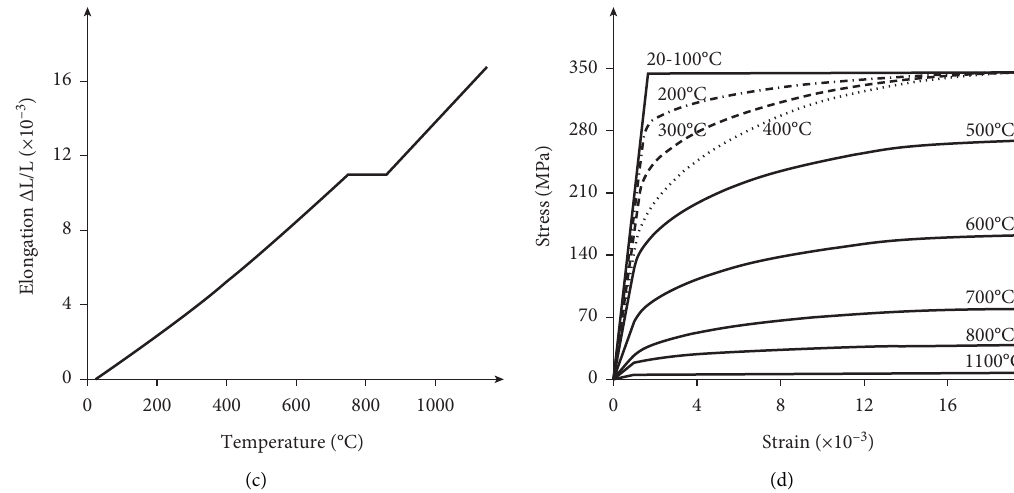
Figure 7: Material property of deck steel: (a) conductivity; (b) specific heat; (c) elongation; and (d) stress–strain relationship.